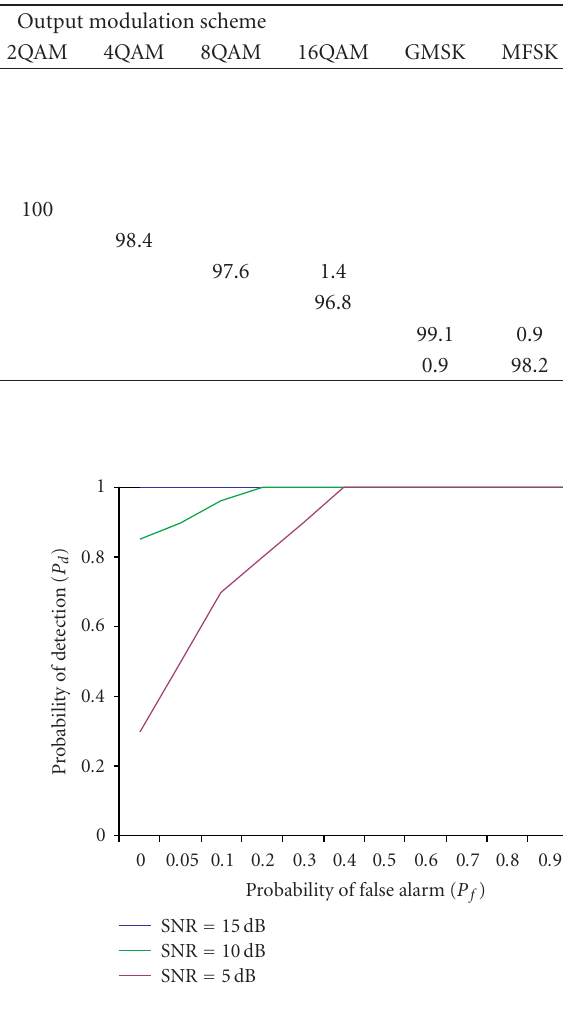
Figure 6: Receiver operating characteristics (ROCs) for the pro- posed system.